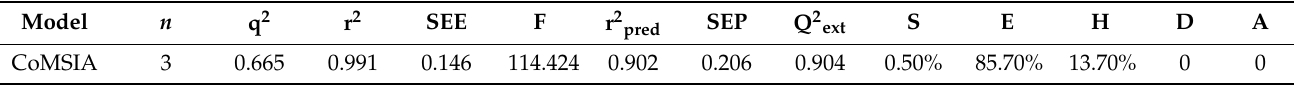
Table 2. Evaluation parameters of the CoMSIA model and the contribution rate of the molecular force field to the pREC 20 values of